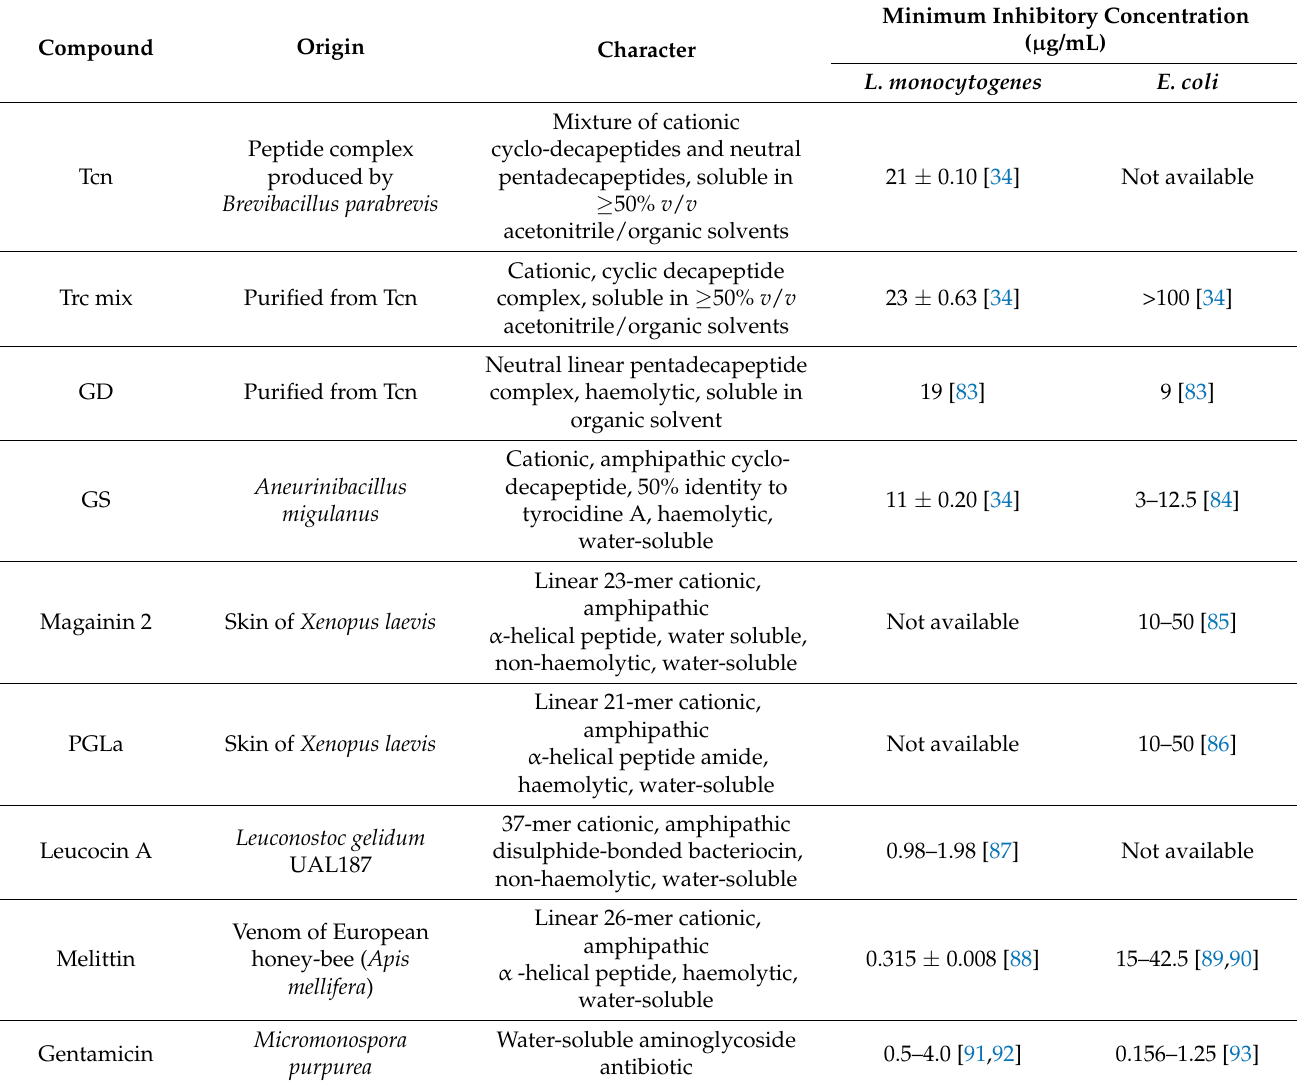
Table 2. Summary of the compounds used to compare with the Trc in creating robust non-covalent antimicrobial